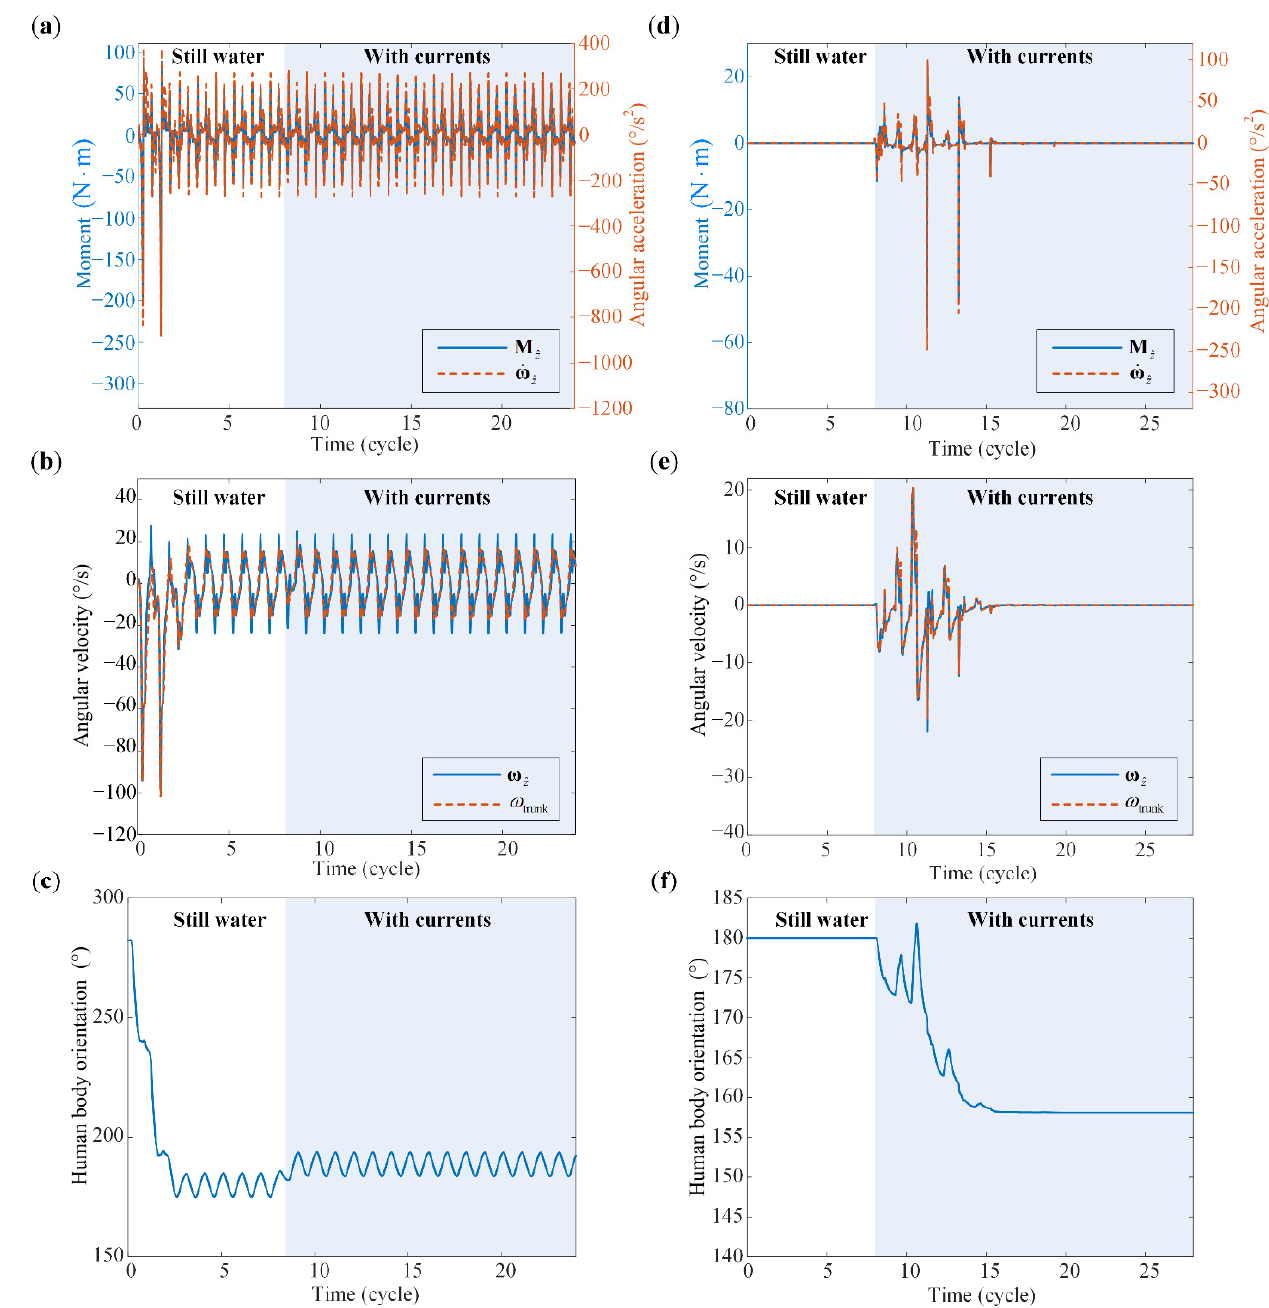
. Figure 5. Time histories of the fluid moment Figure 5. Time histories of the fluid moment M ω ˆ z and the angular velocity ˆ z , the angular acceleration ω ˆ z about the principal axis of inertia ˆ z , the change rate of the human trunk orientation ω trunk , and the human trunk orientation θ trunk . The current is applied after the 8th cycle, the current direction is 60 ◦ , and the current velocity is 1 height/cycle. ( a – c ) Freestyle swimming, ( d – f ) breaststroke swimming. Overall, the above analyses reveal that the fluid moment is the major factor that determines the human body orientation during swimming. When the current is